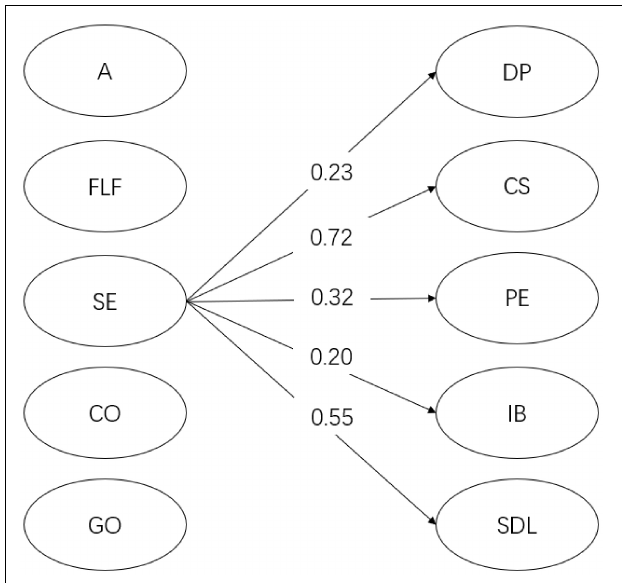
FIGURE 2 | The SEM model for year 1 students. Only significant relations are presented in the figure. DP, doing previews; CS, in-class communication self-efficacy; PE, positive experience of flipped classroom; IB, intentional behaviors; SDL, self-directed learning; A, autonomy; FLF, formative learning feedback; SE, English learning self-efficacy; CO, communication-oriented learning; GO, grammar/translation-oriented learning.